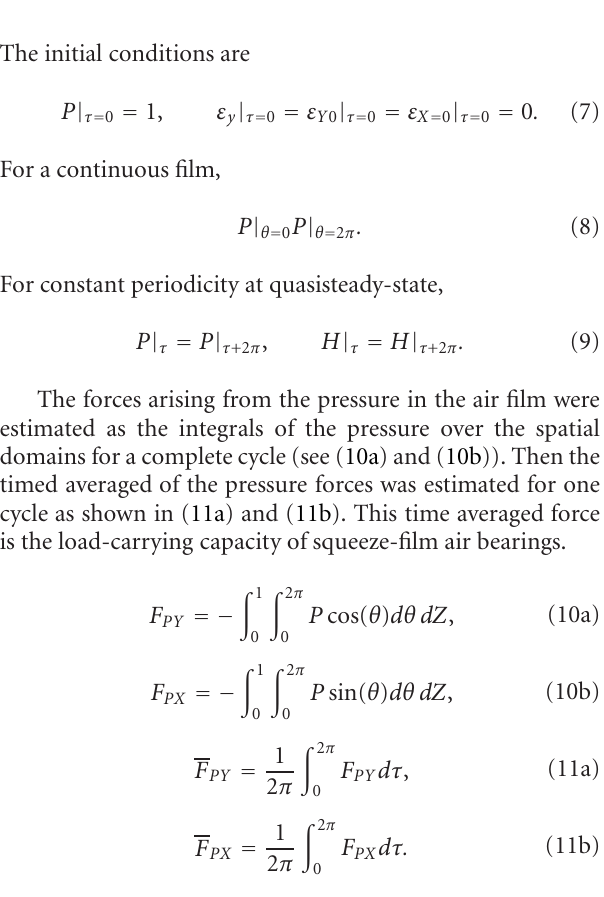
Figure 1: (a) Photograph of the test bearing shell with arrangements of piezoelectric actuators. (b) The static three-lobe geometry of the bearing (not to